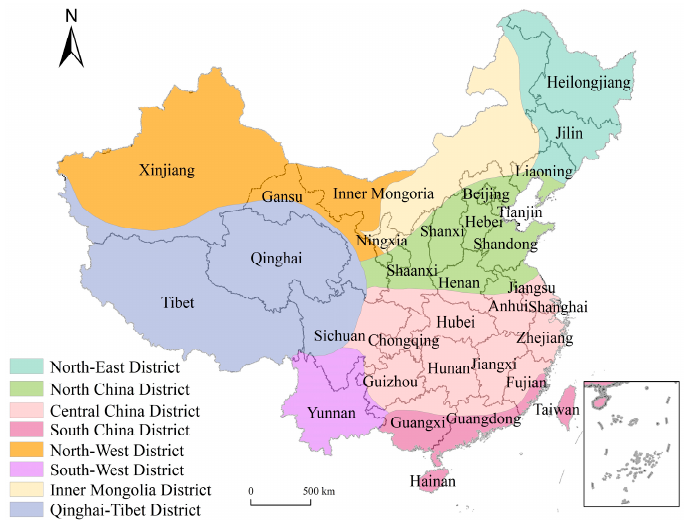
Figure 1. The 31 provinces of China in this study.